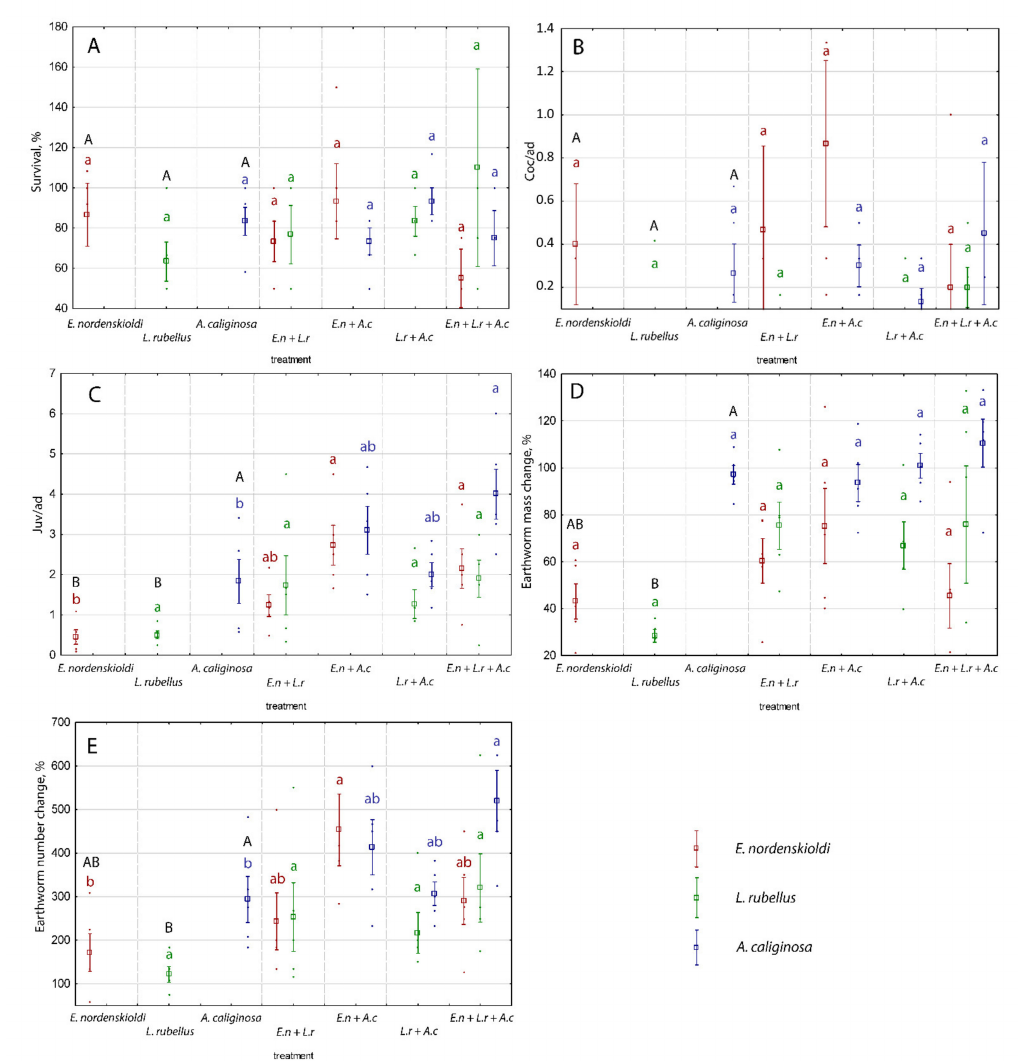
Figure 1. Indicators of earthworm population in different variants of the vegetation experiment in mesocosms (Mean ± SE, raw data). ( A ) survival rate of sexually mature animals, % of the initial number, ( B ) productivity, number of cocoons/number of sexually mature individuals, ( C ) number of immature/number of sexually mature, ( D ) % of the starting biomass, and ( E ) % of the initial number. Variants with different letters show significant differences ( α = 0.05 Tukey HSD). Capital letters show differences between species; small letters—between the